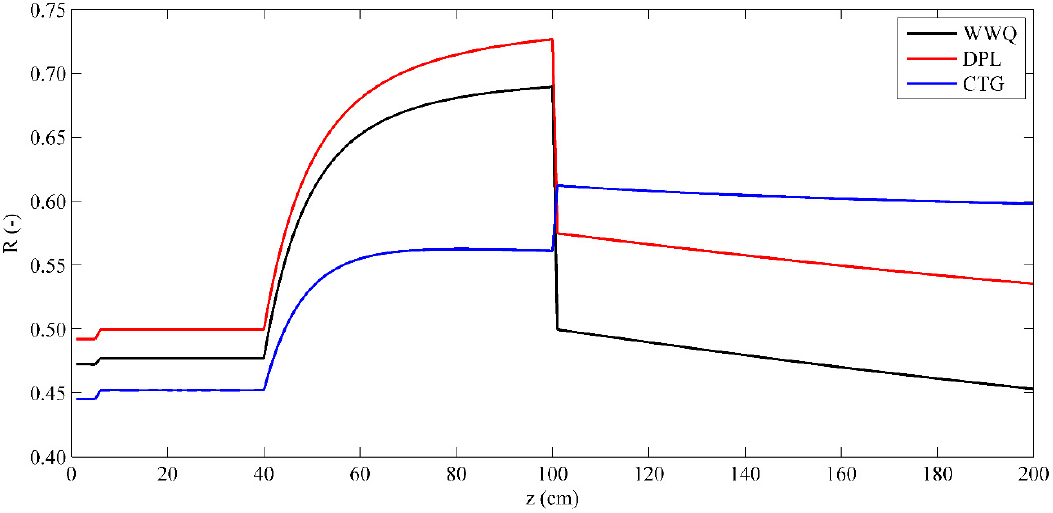
Figure 3. The correlation coefficient (R) between soil water storage of MISDc and CLDAS at different depths for the 315 three basins. depths for the three